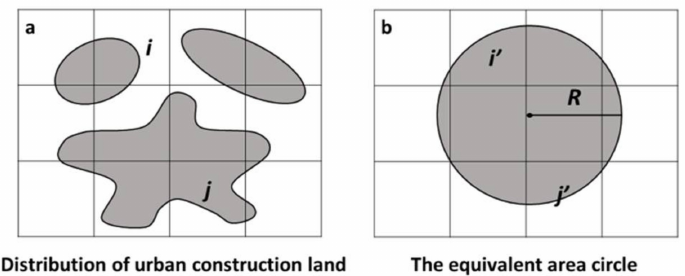
Figure 3. Urban construction land and its equivalent circular land [34].